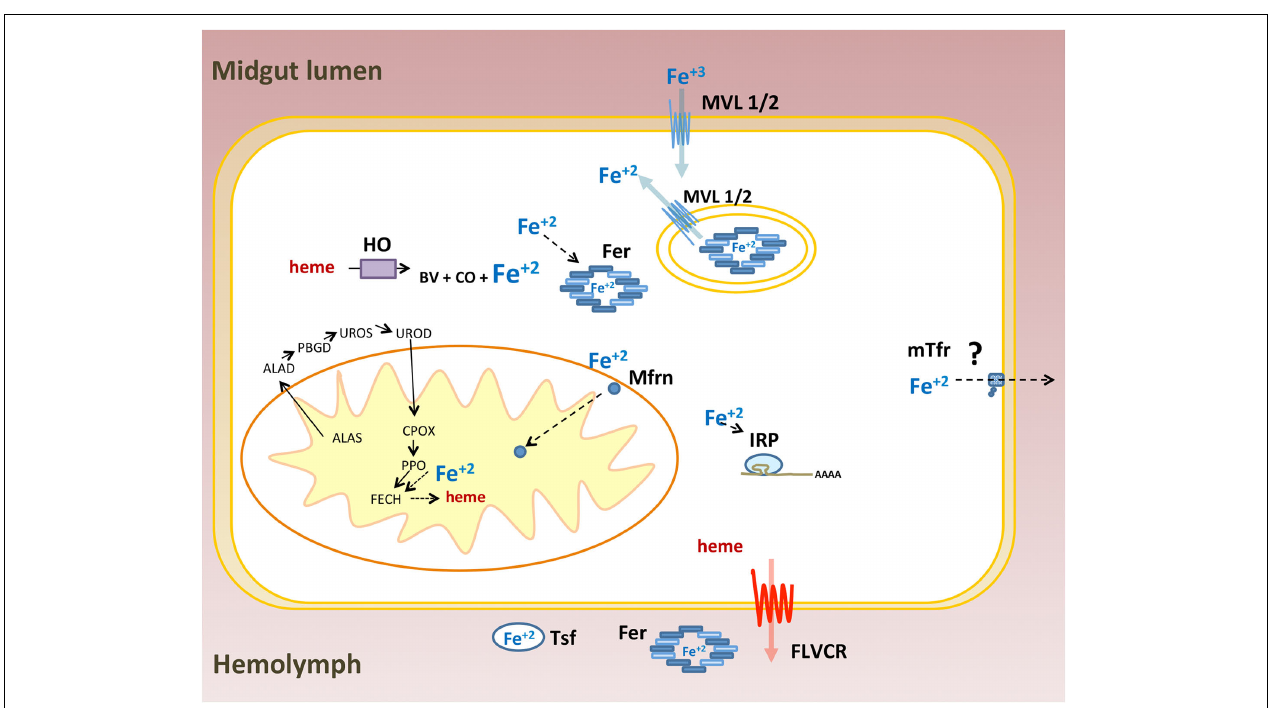
FIGURE 13 | Schematic representation of iron and heme related genes identified in the Rhodnius prolixus genome: Ferritin (Fer), Iron Regulatory Protein (IRP), Transferrin (Tsf), Melanotransferrin (mTsf) Malvolio (MLV1/2), Mitoferrin (Mfrn), Aminolevulinic Acid Synthase (ALAS), Delta-Aminolevulinic Acid Dehydratase (ALAD), Porphobilinogen deaminase (PBGD), Uroporphyrinogen III Synthase (UROS), Uroporphyrinogen Decarboxylase (UROD), Coproporphyrinogen III Oxidase (CPOX), Protoporphyrinogen oxidase (PPOX), Ferrochelatase (FECH), Heme oxygenase (HO) and Feline Leukemia Virus C Receptor (FLVCR). ZIP proteins were